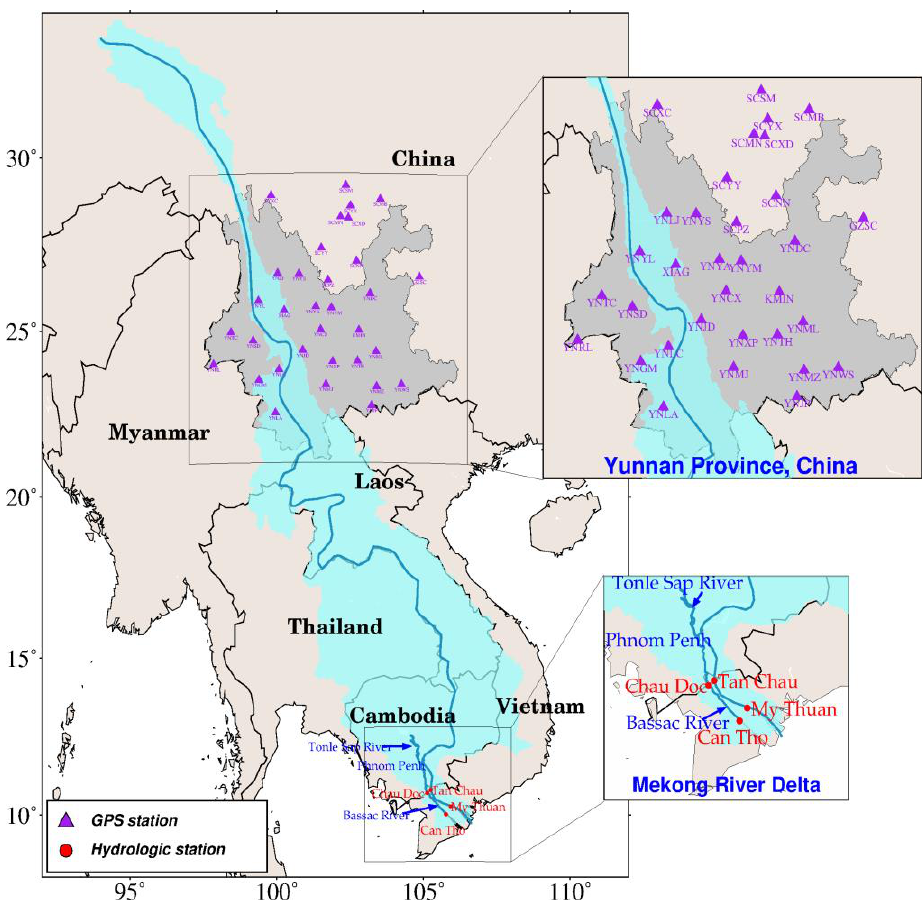
Figure 1. Indochina Peninsula including Yunnan Province (China) (bounded in grey) covered with GPS stations (purple triangle) and Mekong Basin (bounded in blue) with in-situ hydrologic stations (red dot) situated in the basin estuary.